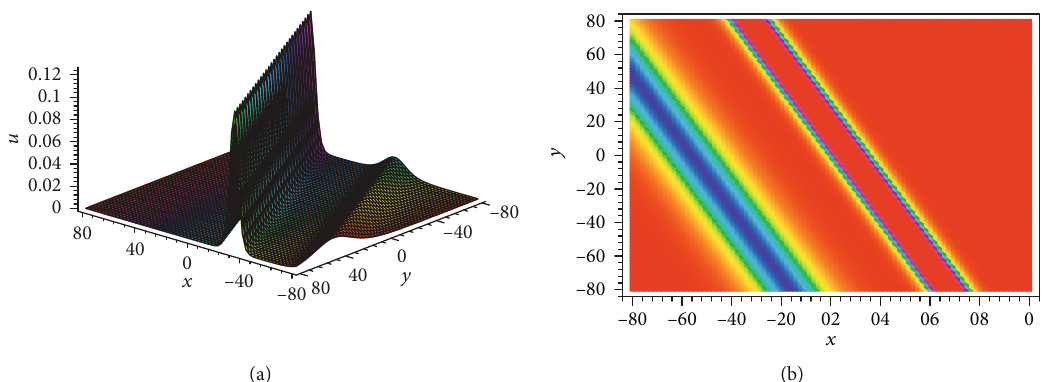
Figure 1: (a) Soliton molecule of the ð 2 + 1 Þ -dimensional higher-order Boussinesq equation. (b) Density plot of the corresponding soliton molecule.